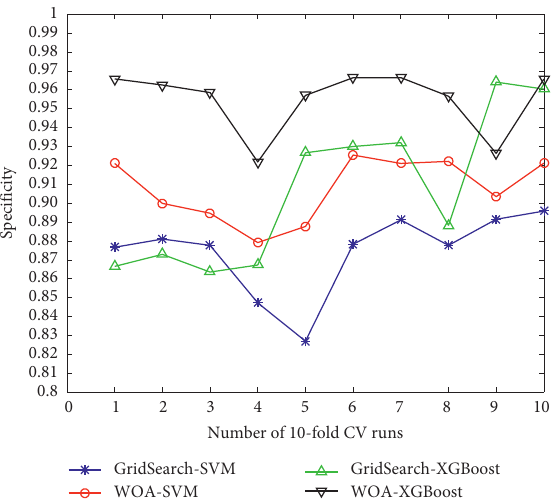
Figure 3: The specificity achieved at each run without feature selection.